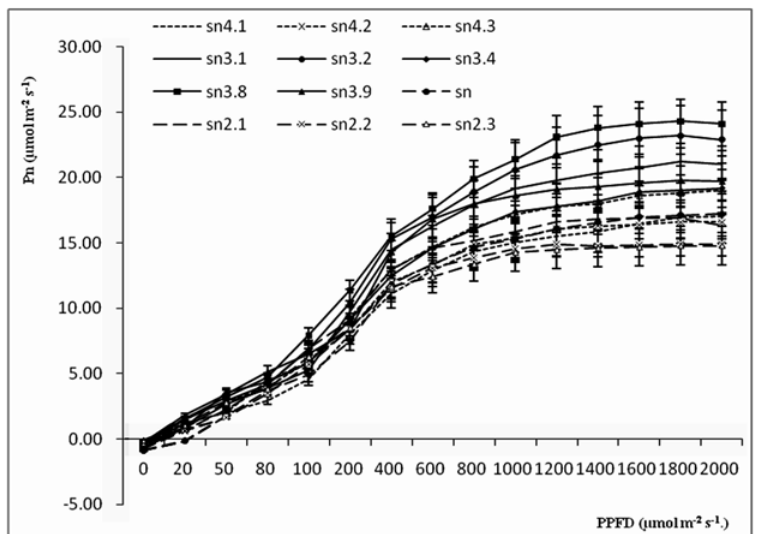
Fig 2. Pn-PPFD curves of poplar clones of different ploidies. Different ploidy clones are shown by different line types and identification. Triploids are shown by solid lines, diploid and tetraploid are shown as different types of dotted and dashed